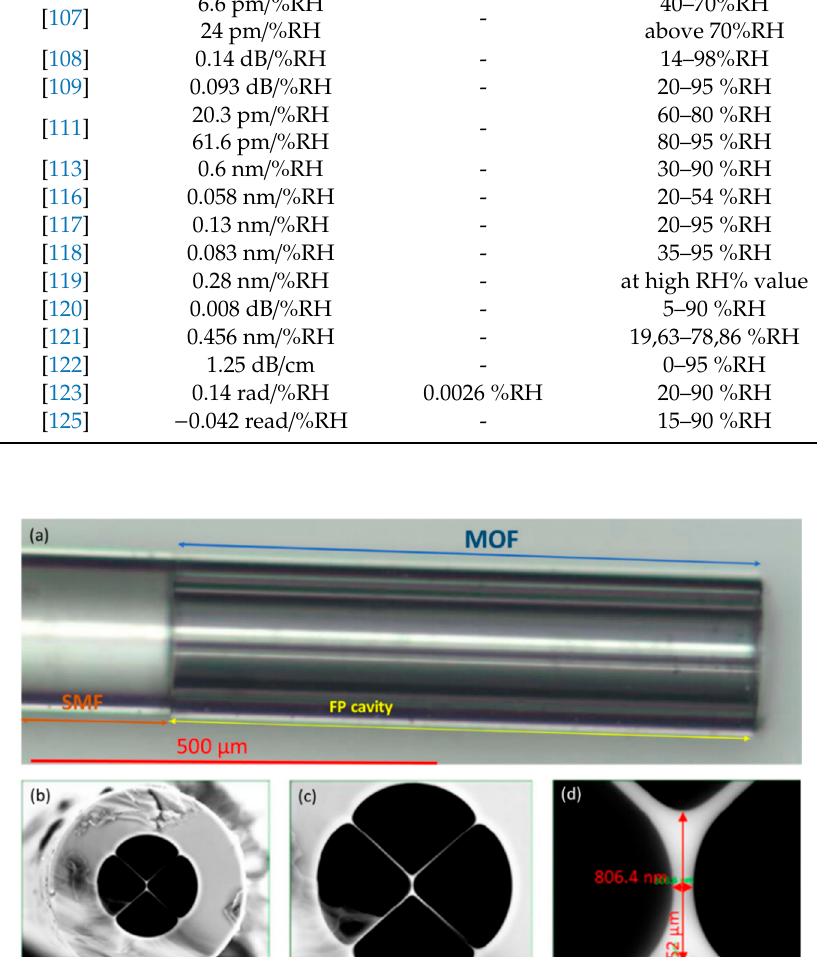
Figure 18. The structure of the FP interferometer constructed by splicing a section of an SC-PCF between a section of SMF and a section of HC-PCF. Reprinted with permission from [121].